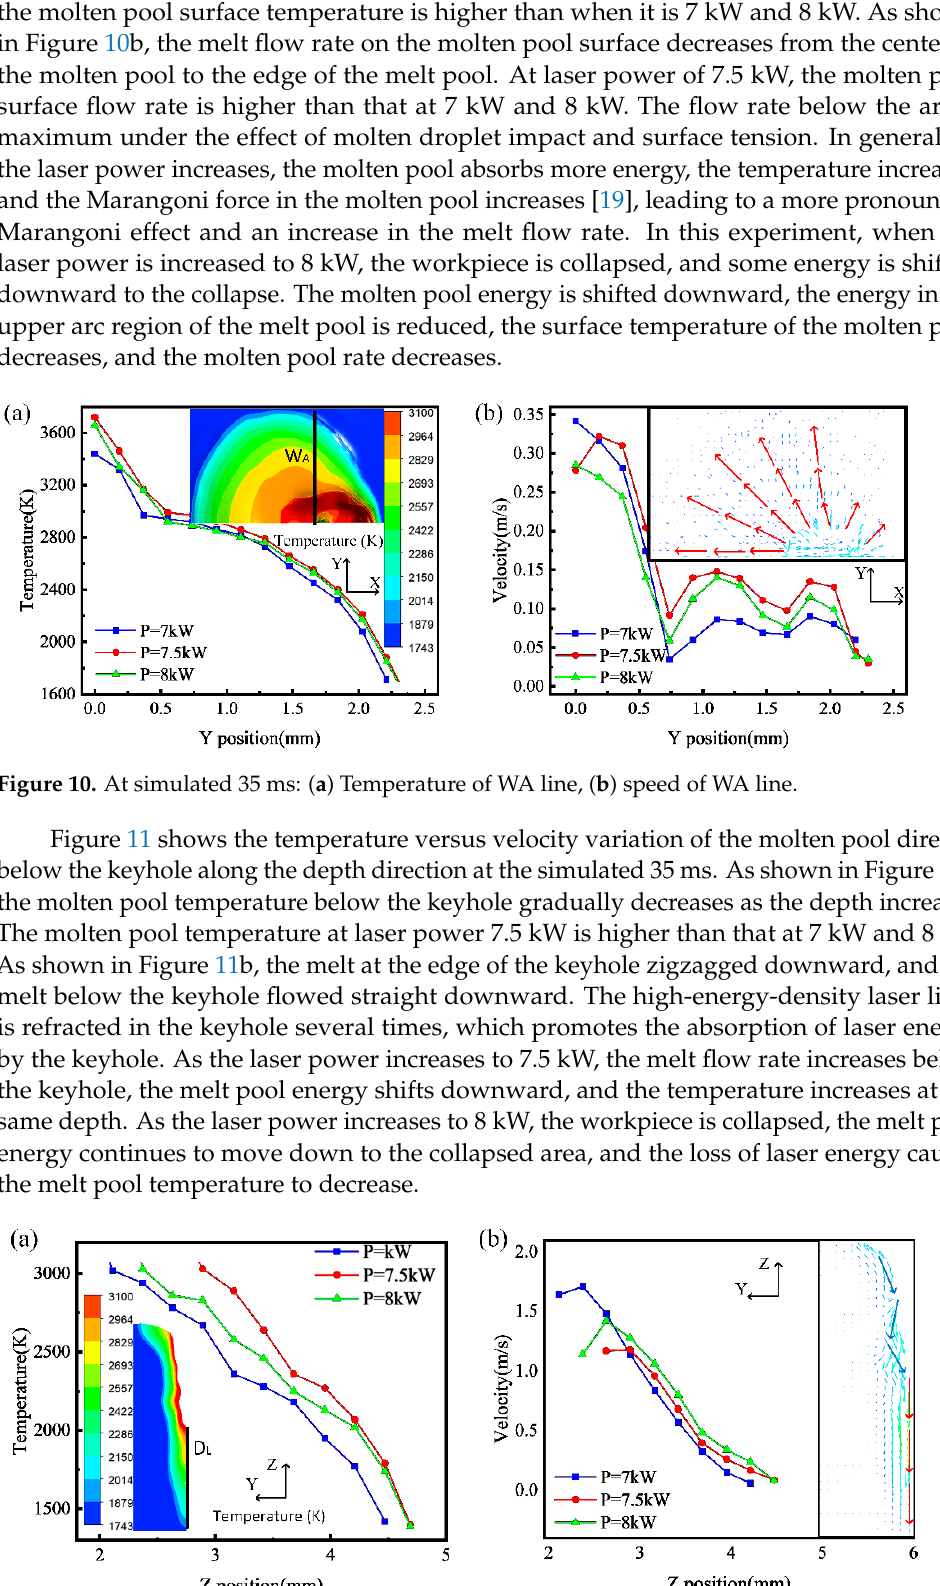
L line, ( b ) speed of D L